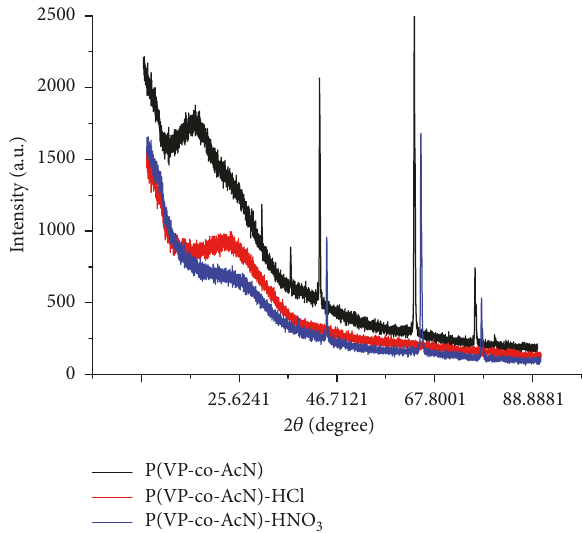
Figure 8: DSC spectra of the copolymer and the polyelectrolytes. ∘ 372 to 455 C (another 59 % loss) which results from the degradation of the copolymer backbone. The copolymer is wholly decomposed above 700 ∘ C.